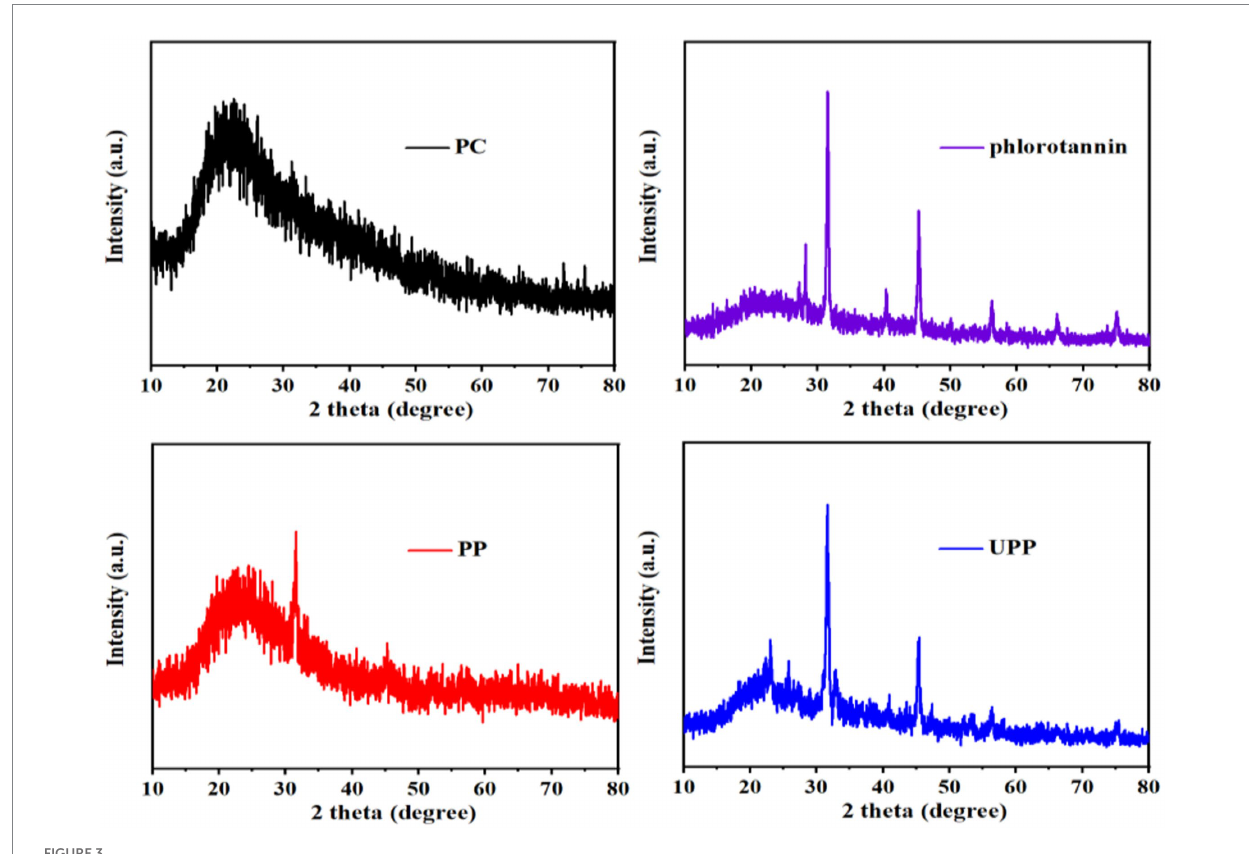
FIGURE 3 XRD patterns of PC, phlorotannin, PP (1:1), UPP